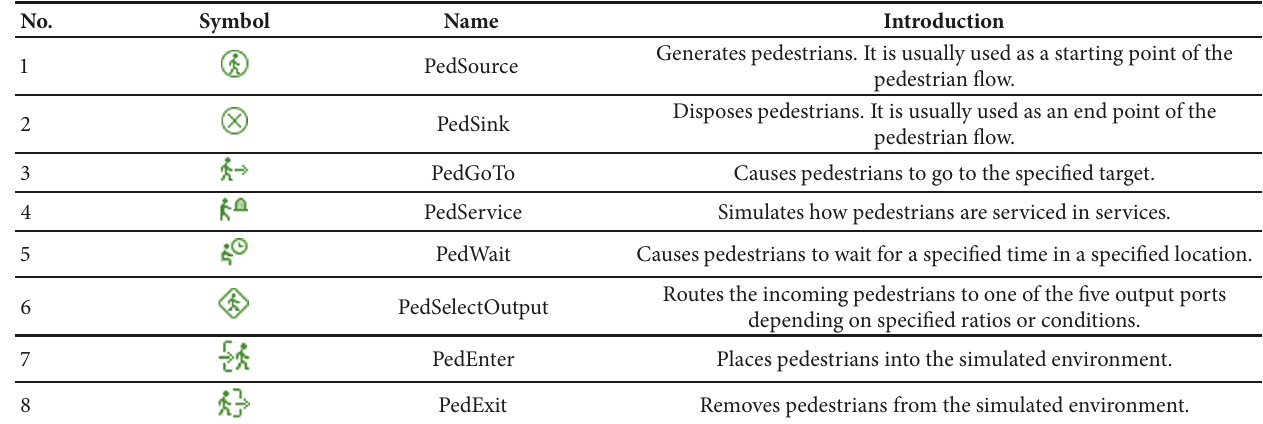
Table 3: Blocks used to simulate passengers flow in